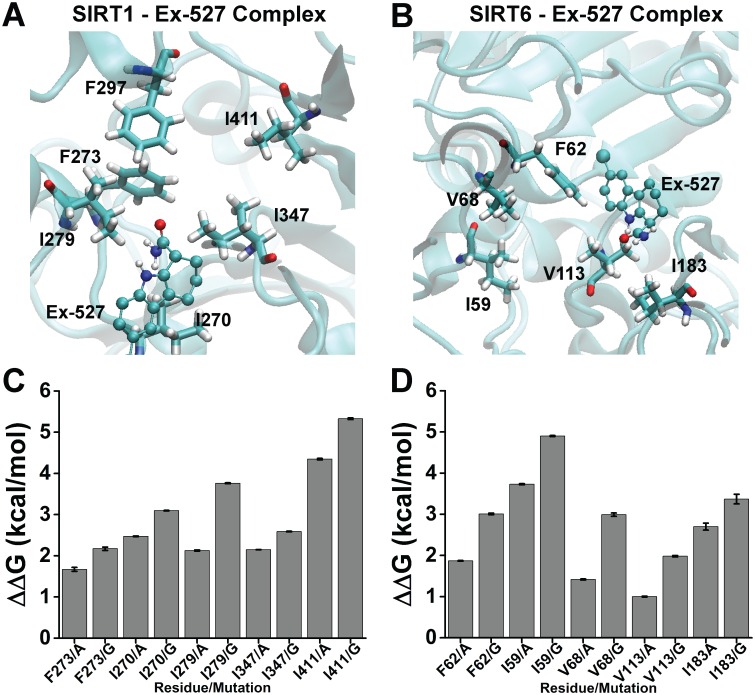
Hydrophobic pockets of SIRT1 and SIRT6.Complexes obtained by docking the inhibitor, Ex-527, to the close proximity of hydrophobic pocket of SIRT1 (A) and to the analogous hydrophobic pocket of SIRT6 (B), were used to simulate the permenance of the binding of the inhibitor to the hydrophobic cluster amino acids. Each amino acid was shown for clear positioning of the pockets. SIRT6 hydrophobic pocket amino acids (B) were predicted based on the corresponding amino acids of SIRT1 (A): V113, I183, I59, F62, V68 of SIRT6 were selected based on similarity to I347, I411, I270, F273, I279 of SIRT1. F297, a member of SIRT1 hydrophobic pocket shown in (A), does not have a corresponding hydrophobic residue in SIRT6 structure (B). (C)(D) Alanine and glycine mutations of SIRT1 hydrophobic pocket residues showed destabilizing characteristic (positive ΔΔG values) similar to the mutations of SIRT6, in part, validating the presence of a hydrophobic pocket in SIRT6 structure. FoldX was used to compute ΔΔG values to determine stability change. Protein structures obtained from PDB ID: 4I5I chain A and PDB ID: 3K35 chain A were used as SIRT1 and SIRT6, respectively.